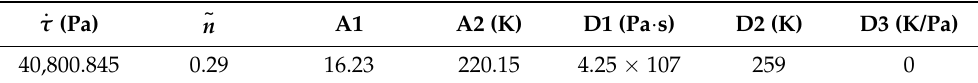
Figure 6. Shear viscosities of PP, POE and theirs blends at 210 °C. Fitting the rheological data to the Cross-WLF viscosity model, seven model parame- ters of PP/POE blends were calculated and listed in Table 5. Table 5. Cross-WLF coefficients of PP/POE blend.